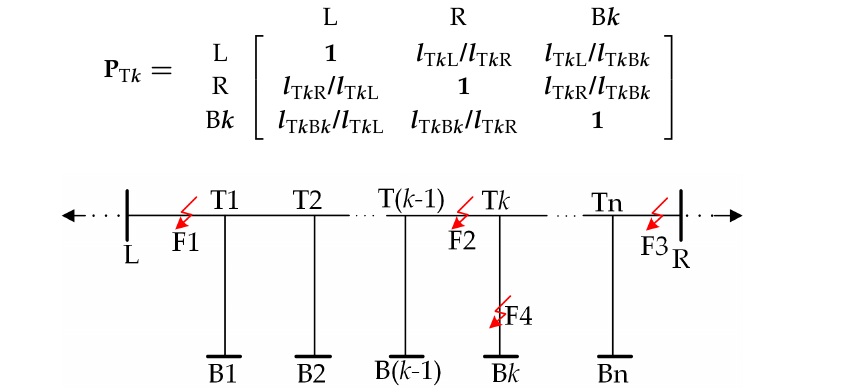
Figure 5. Diagram of a multi-terminal transmission line.